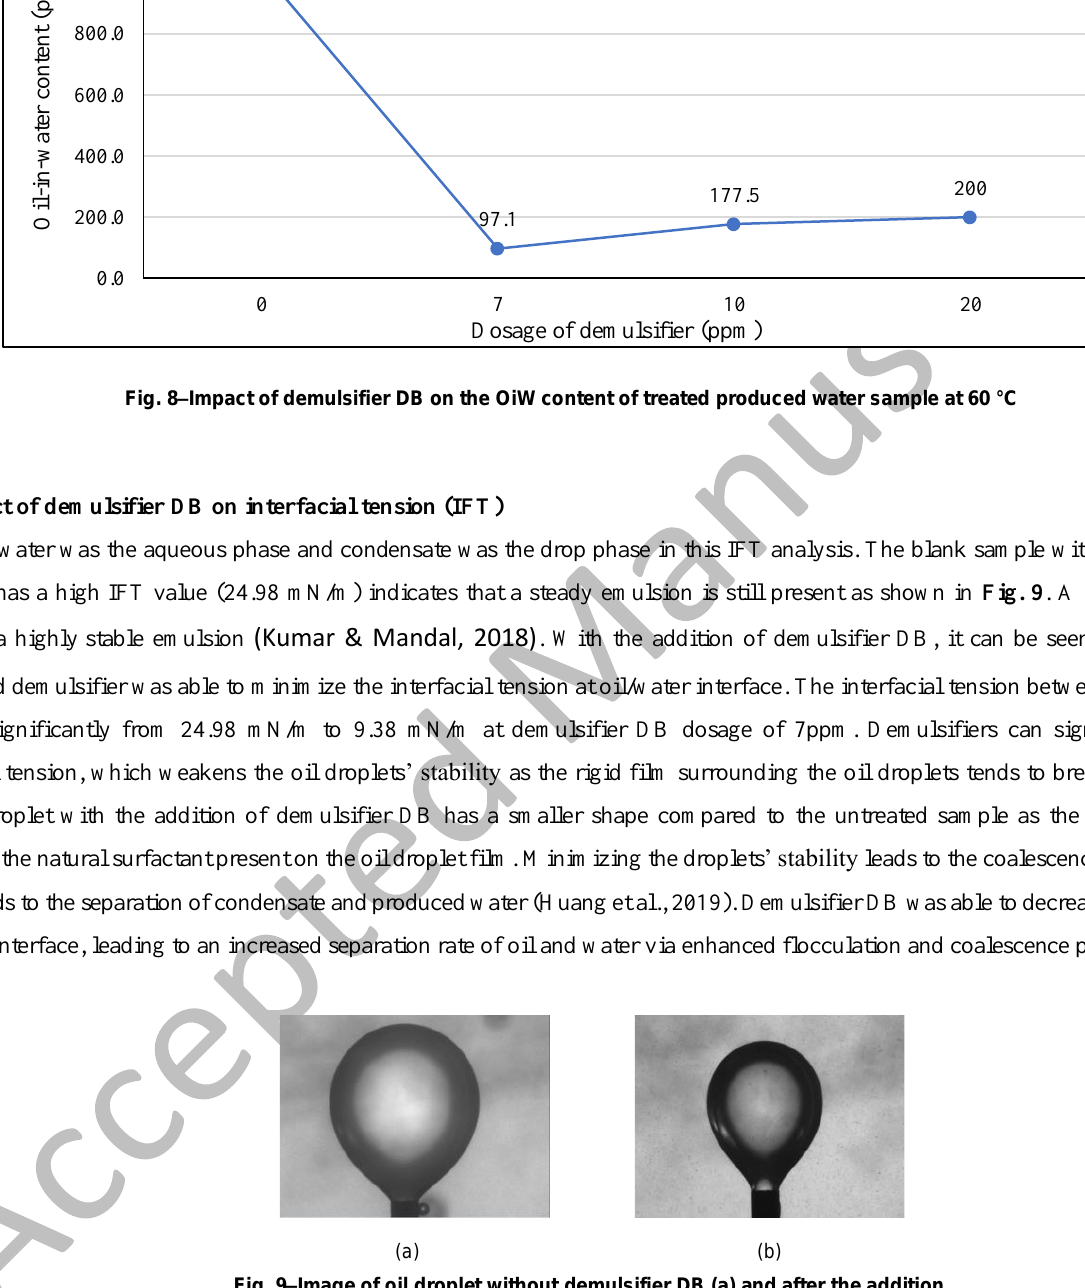
Fig. 9–Image of oil droplet without demulsifier DB (a) and after the addition of demulsifier DB dosage at 7ppm